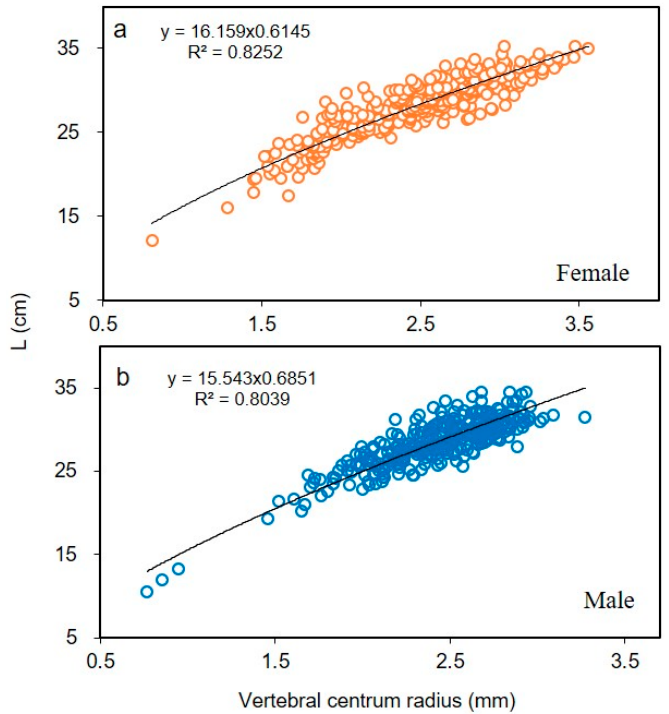
Figure 9. Relationship between vertebral centrum radius and disc width of ( a ) female and ( b ) male specimens of Okamejei kenojei collected from the West Sea of South Korea.